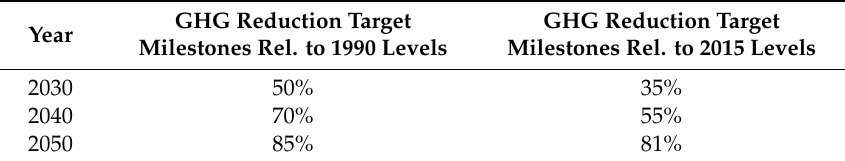
Table 1. Milestone targets of the analyzed reduction